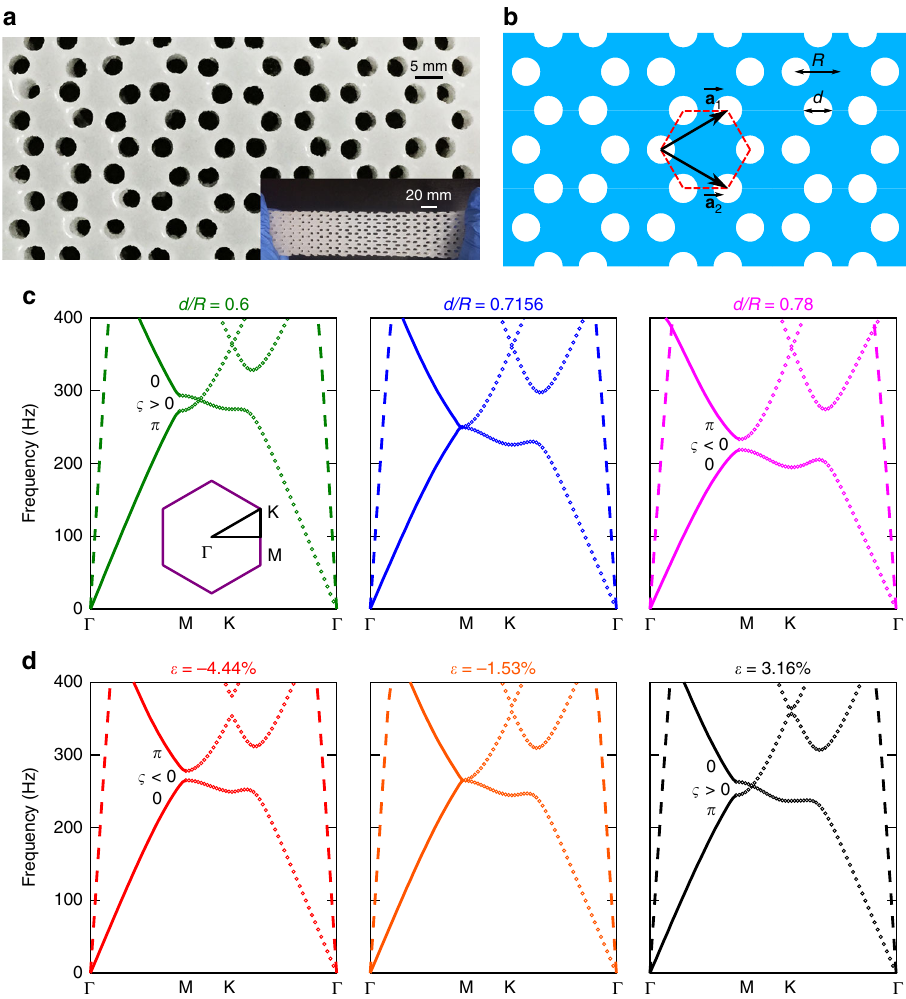
Fig. 1 Design of topological elastic metamaterials and two band inversion processes. a Soft elastic metamaterial with periodic honeycomb holes of air in a rectangle silicon rubber (Eco fl ex). The inset shows the stretchability of the soft metamaterial. b The schematic of our soft elastic metamaterials. Red ! ! dashed hexagon is the primitive cell with the hexagon edge length R and hole ’ s diameter d . a 1 and a 2 are the basic vectors. c Band inversion process as a function of fi lling ratio of d / R without applied strain. The fi lling ratios of d / R chosen are 0.6, 0.7156, and 0.78. Dashed lines indicate longitudinal wave bands. Solid lines and dotted lines indicate transverse wave bands in Γ M direction and other directions, respectively. Inset is the irreducible Brillouin zone. d Band inversion process as a function of strain with fi xed fi lling ratio of d / R = 0.68. Three strains chosen from compression to tension are − 4.44, − 1.53, and 3.16%. The calculated Zak phase could be 0 or π , which is marked on the corresponding bulk band in Γ M direction (solid lines) in c and d . The calculated bandgap signs ς are marked in the corresponding bandgap. All band structures are from numerical